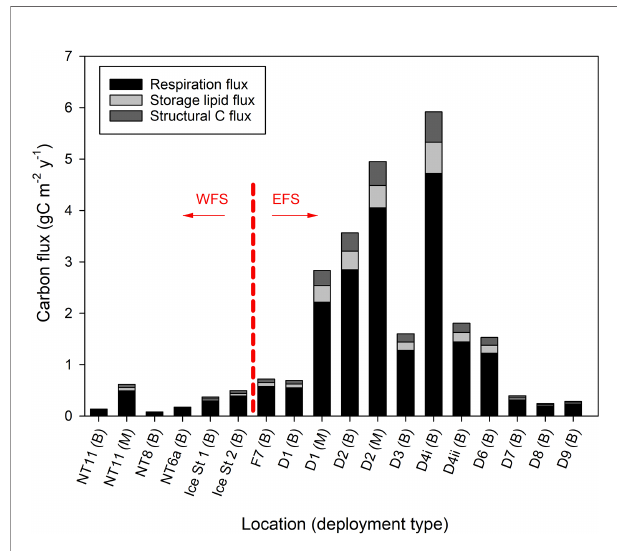
FIGURE 6 | Calanus fi nmarchicus : carbon fl ux (gC m − 2 year − 1 ) as a result of respiration during diapause and mortality (divided into storage lipid and structural carbon) at locations sampled in the Fram Strait either by MOCNESS (M) or Bongo (B). Station locations are arranged according to whether they occur in the West Fram Strait (WFS) and East Fram Strait (EFS)